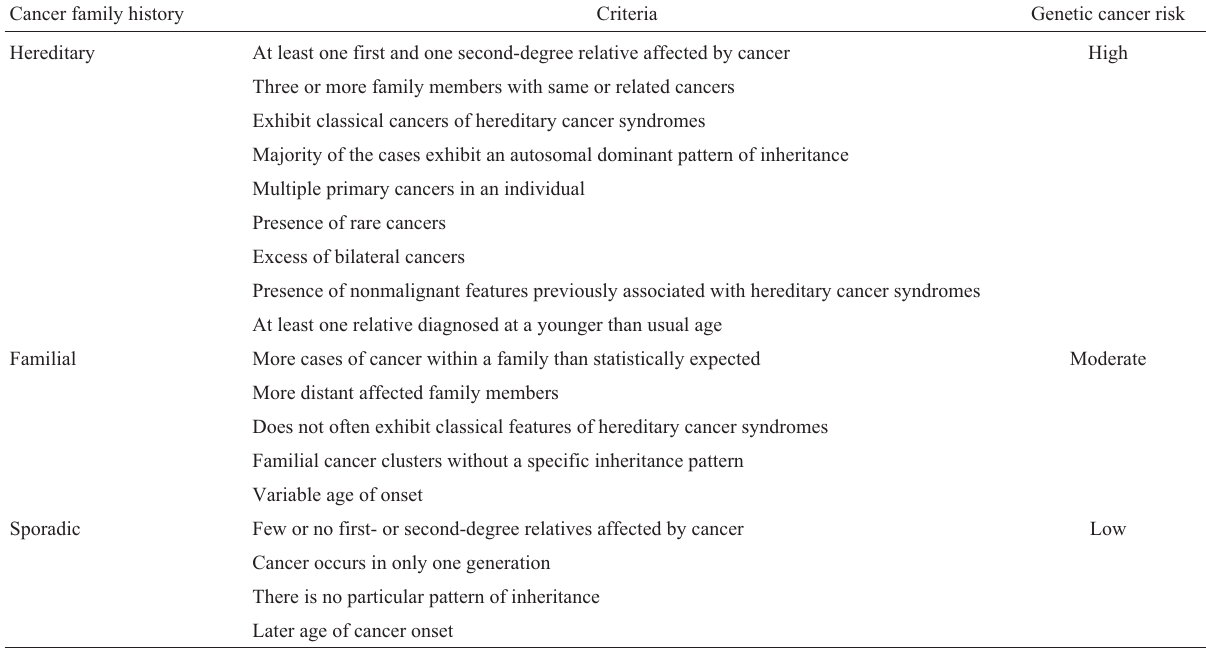
Table 1 - Criteria for cancer family history and genetic cancer risk classification. Cancer family